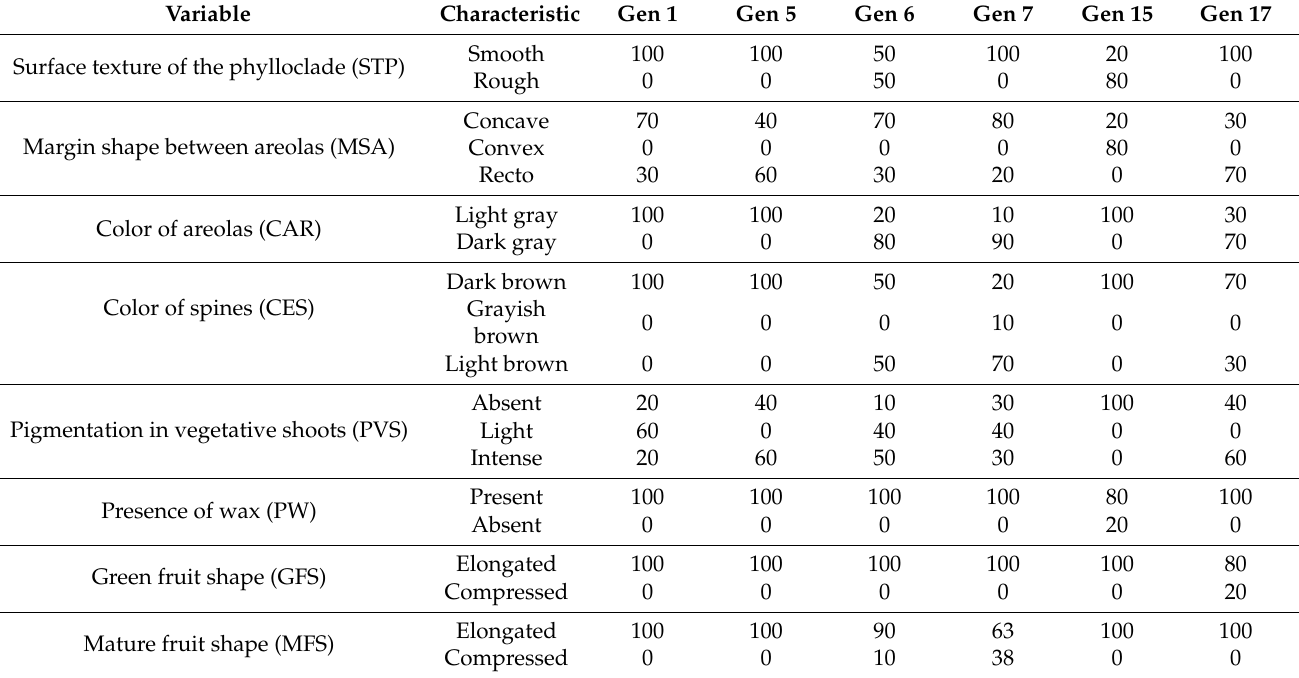
Table 7. Frequency analysis of the qualitative descriptors used in the morphoagronomic char- acterization of the yellow pitahaya genotypes in the open-field system in the municipality of Miraflores, Boyac á